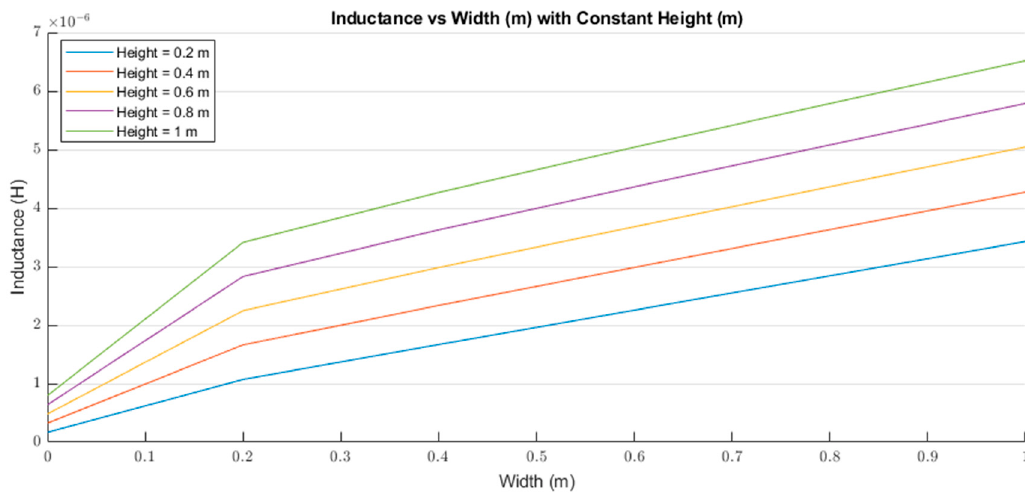
Figure 3. Inductance (H) behavior based on the height (m) and width (m) of a rectangle loop.